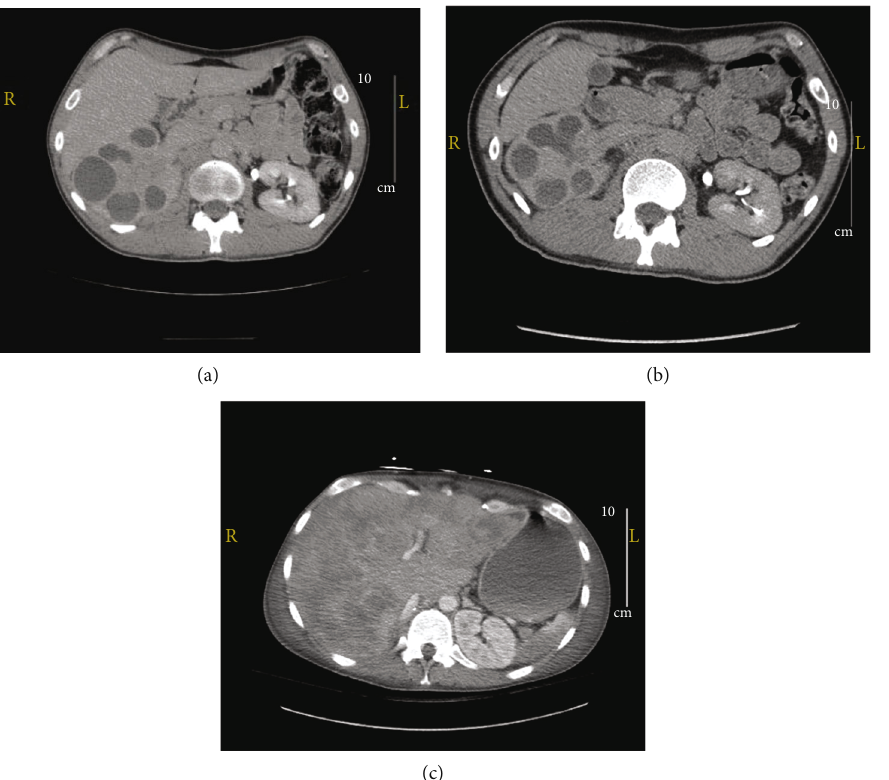
Figure 1: Radiographic fi ndings. (a) Contrast-enhanced CT abdomen on initial presentation demonstrating an enlarged right kidney with hydronephrosis and perinephric stranding which is consistent with the “ bear claw sign ” that suggests XGP. (b) Contrast-enhanced CT abdomen prior to nephrectomy demonstrating aggressive progression of right kidney disease with invasion of surrounding structures. (c) Contrast-enhanced CT abdomen demonstrating multiple biopsy-con fi rmed metastatic liver lesions from urothelial